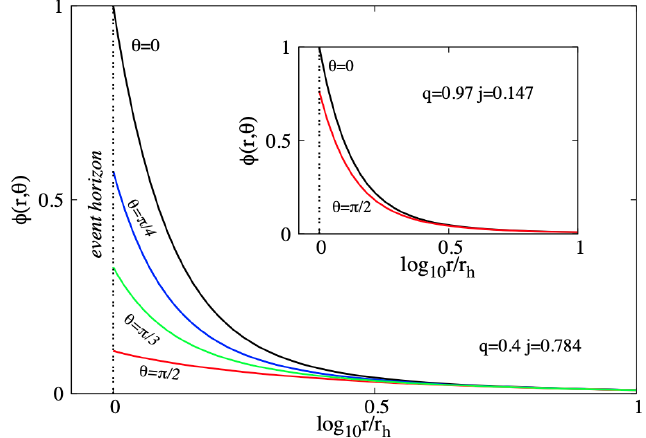
Figure 6. The profile of typical scalar clouds are shown for two Kerr-Newman backgrounds with different values of the reduced charge and angular momentum ( q , j )